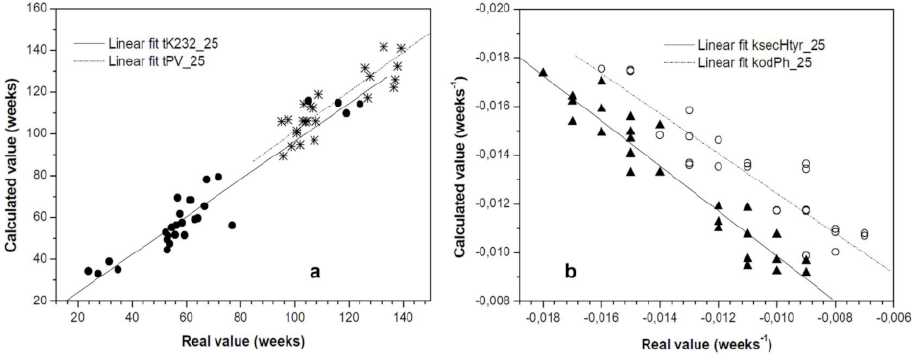
Figure 4. Real and calculated values from predictive equations. • , tK232_25; ж , tPV_25; (cid:78)